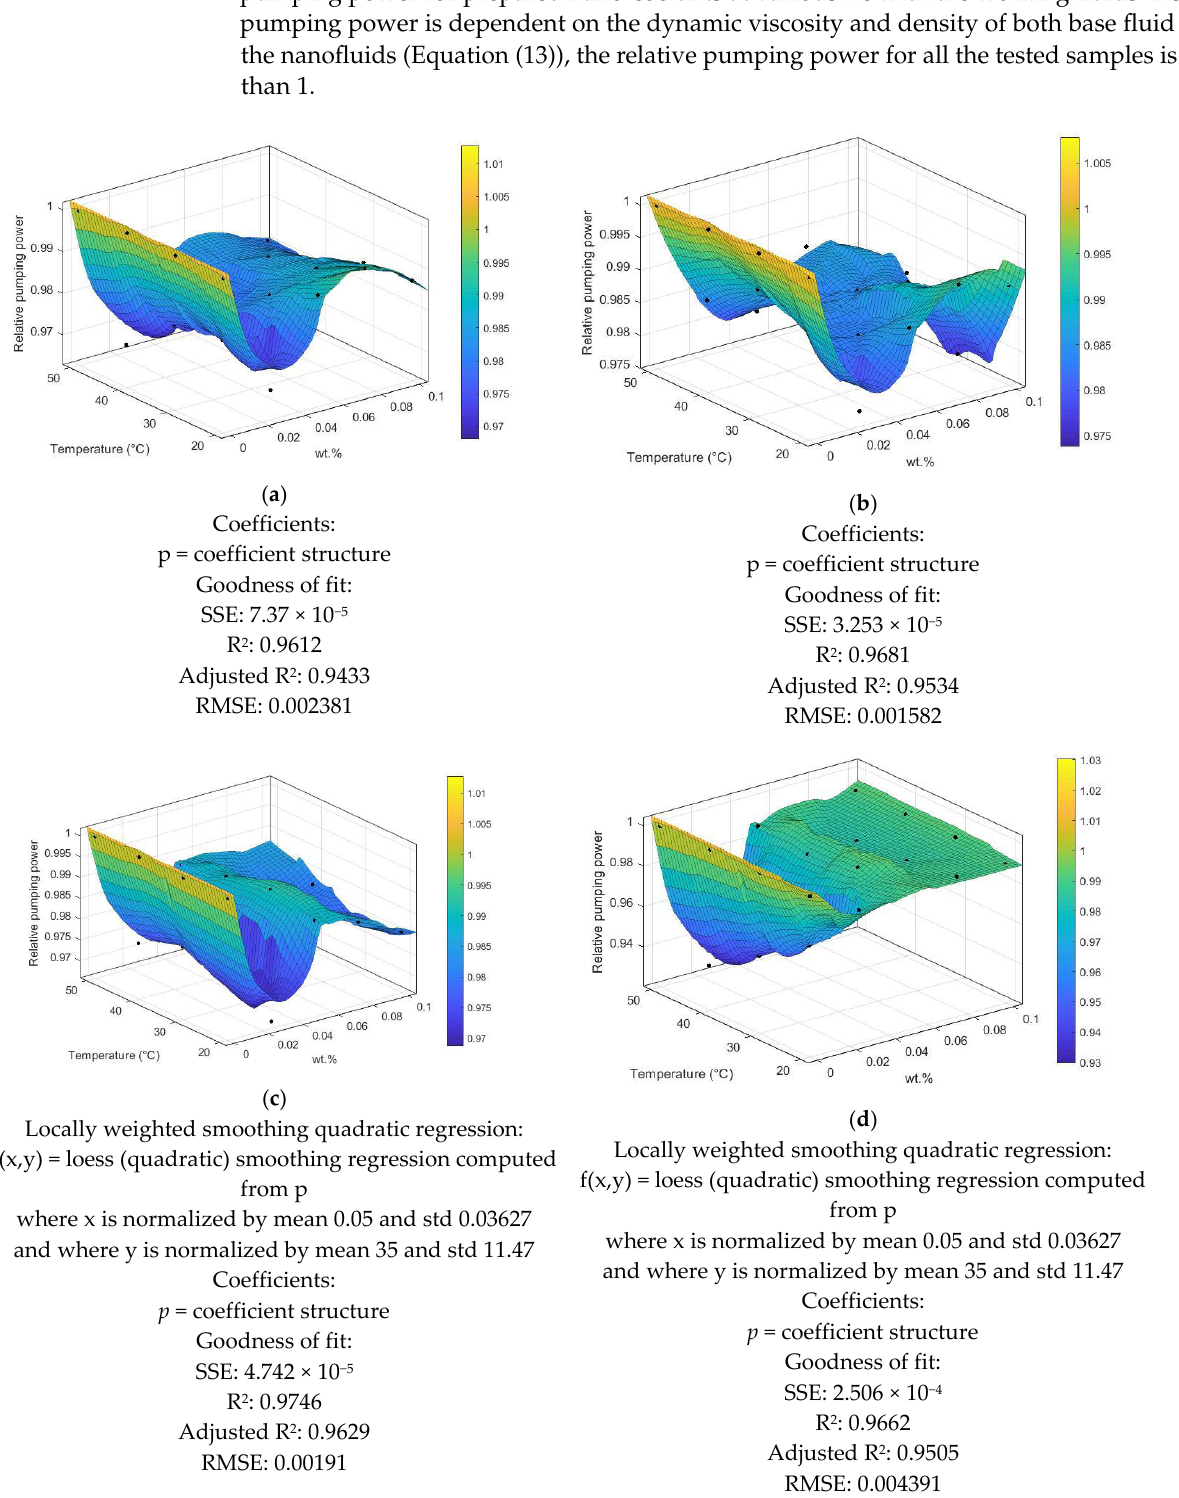
Figure 11. Relative pumping power of different nanofluids against different temperatures and various wt.%, (a) PEG@GNP, (b) PEG@TGr, (c) SiO 2 , and (d) Al 2 O 3 .